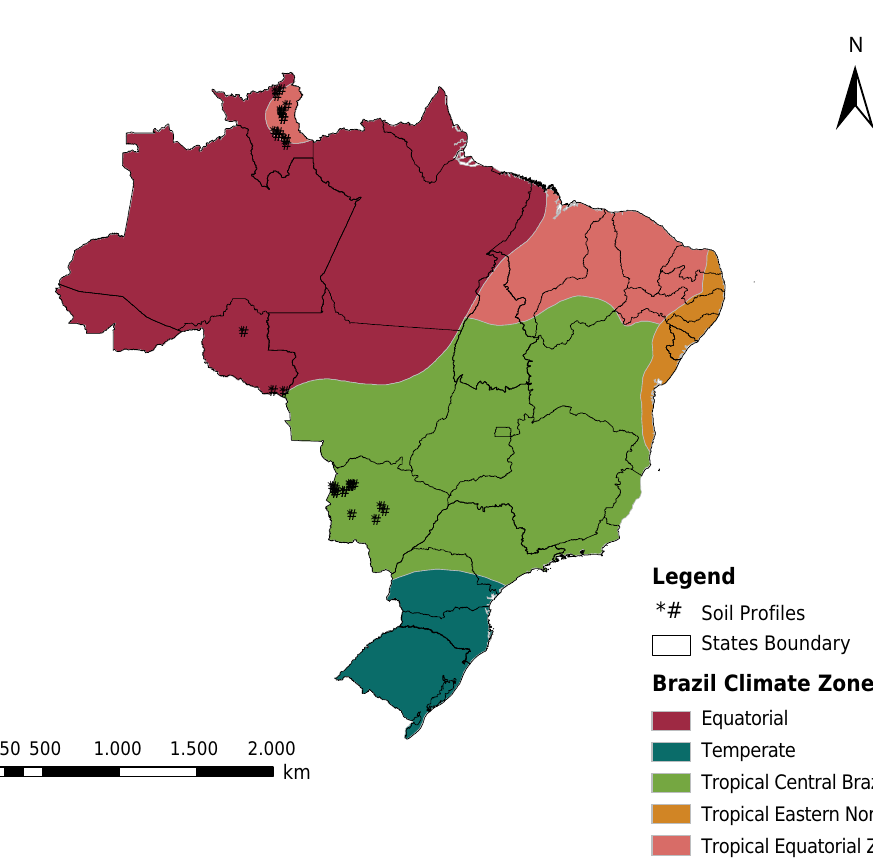
Figure 1. Soil map profiles of the data set and the Brazil climate